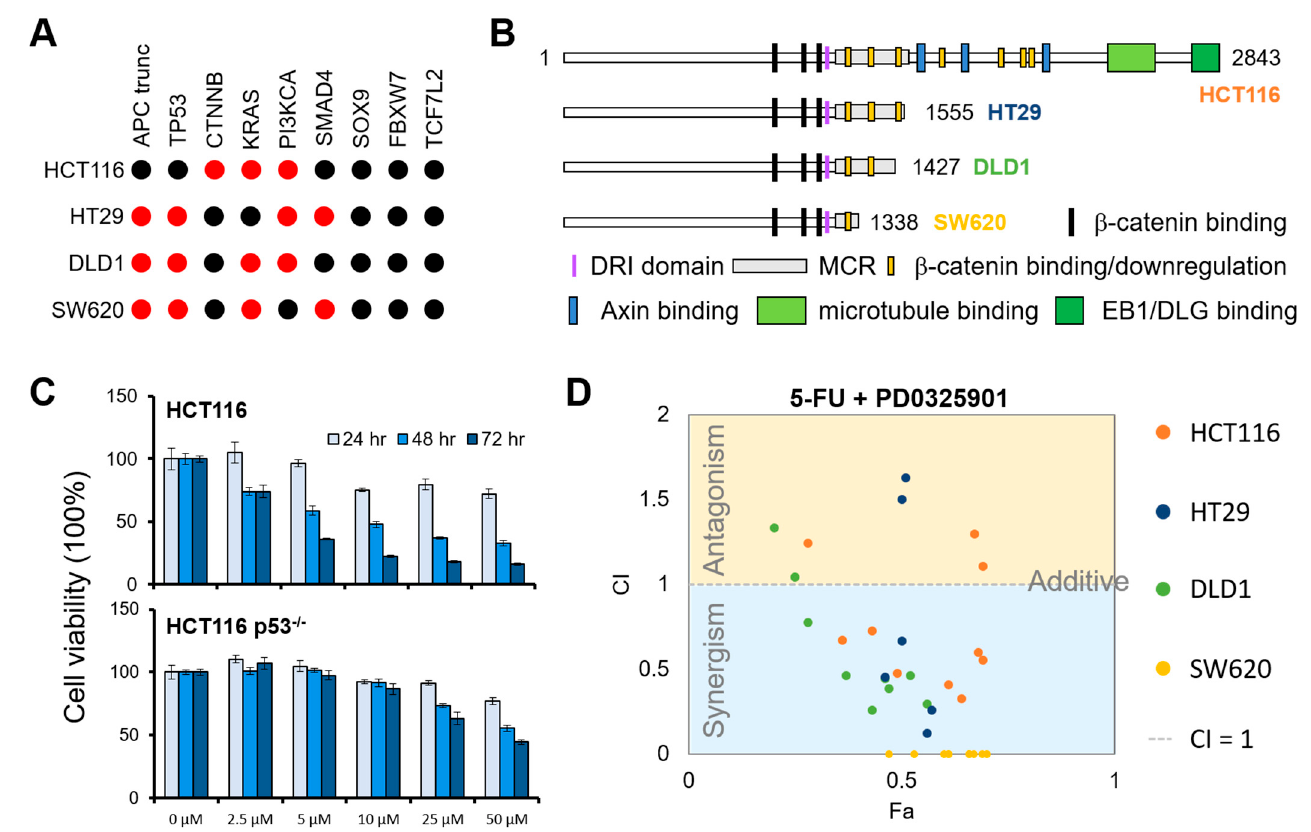
Figure 2. Combinatorial effects of 5-FU with targeting p53 pathway or ERK/MAKP signaling: ( A ) The genetic status of frequently mutated genes in CRC cell lines was used. Wild-type and genes harboring mutations are colored in black and red, respectively. ( B ) APC status in cell lines was tested. Cell lines were colored corresponding to the data in ( D ). ( C ) Inhibition of p53-mediated pathway contributed to 5-FU resistance. P53 null HCT116 (p53 − / − ) cells or parental HCT116 cells were treated with 5-FU for 24, 48, and 72 h at indicated concentrations. Cell viability was measured by MTS assay and normalized to DMSO treated control. (D) Quantitation of synergism and antagonism in MEK inhibitor and 5-FU combination. Fraction affected (Fa) versus Combination Index (CI) plots were generated by CompuSyn. CI indicates a greater/synergism (CI < 1), lesser/antagonism (CI > 1), or similar (CI = 1) effect than the expected additive effect.